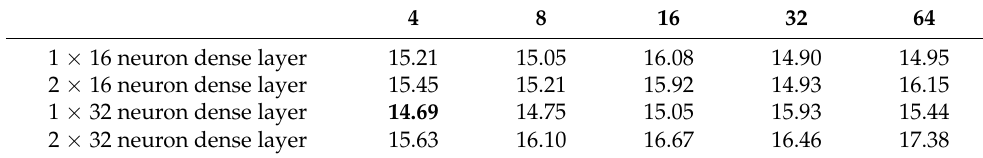
Table 2. RMSE for each model built with each combination of the number of feed forward hidden units (in rows) and the number of hidden units in the LSTM layer.